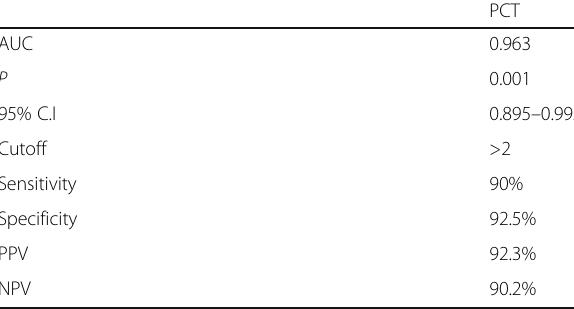
Table 2 The receiver operating characteristic (ROC)